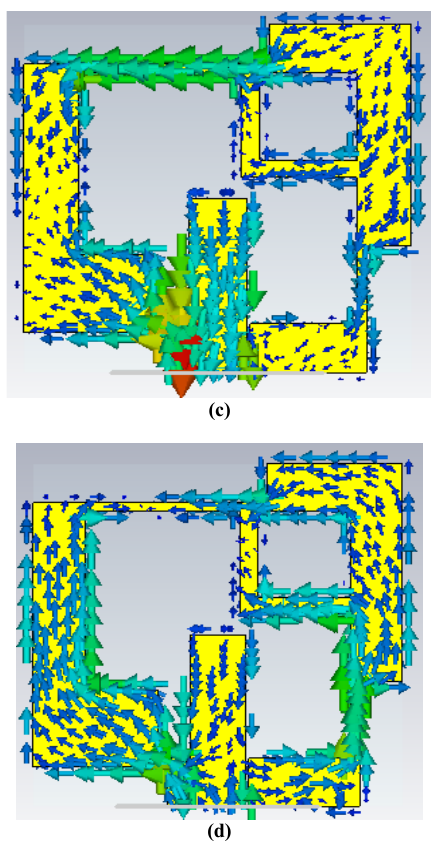
Fig. 12. Computer-generated surface current spreading at 5.2 GHz: (a) 0°; (b) 90°; (c) 180° and (d)